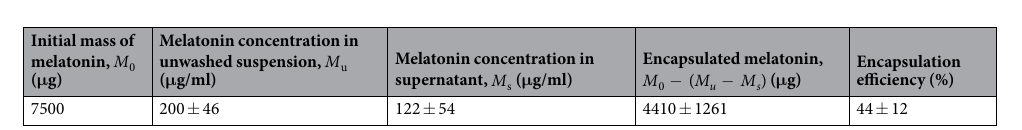
Table 1. Percent encapsulation efficiency of melatonin in PolyRad